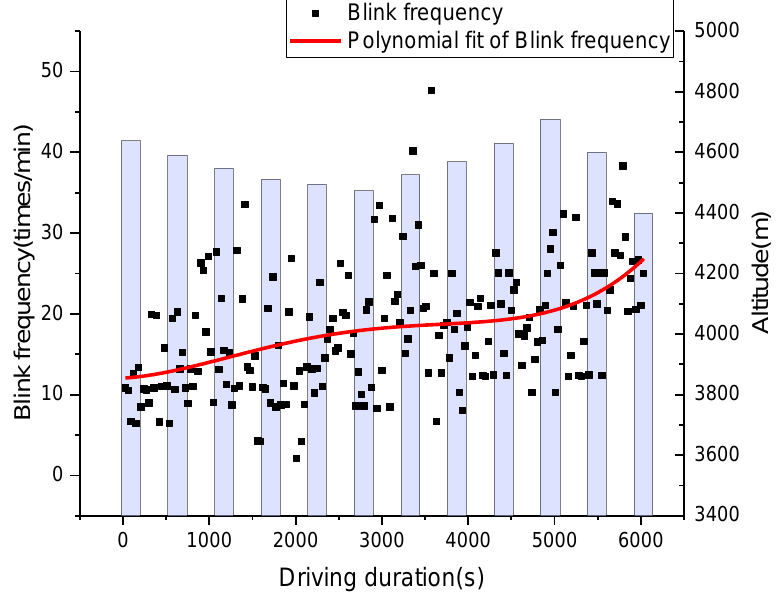
Figure 7. Variations in blinking frequency with altitude and driving duration of segment 2.